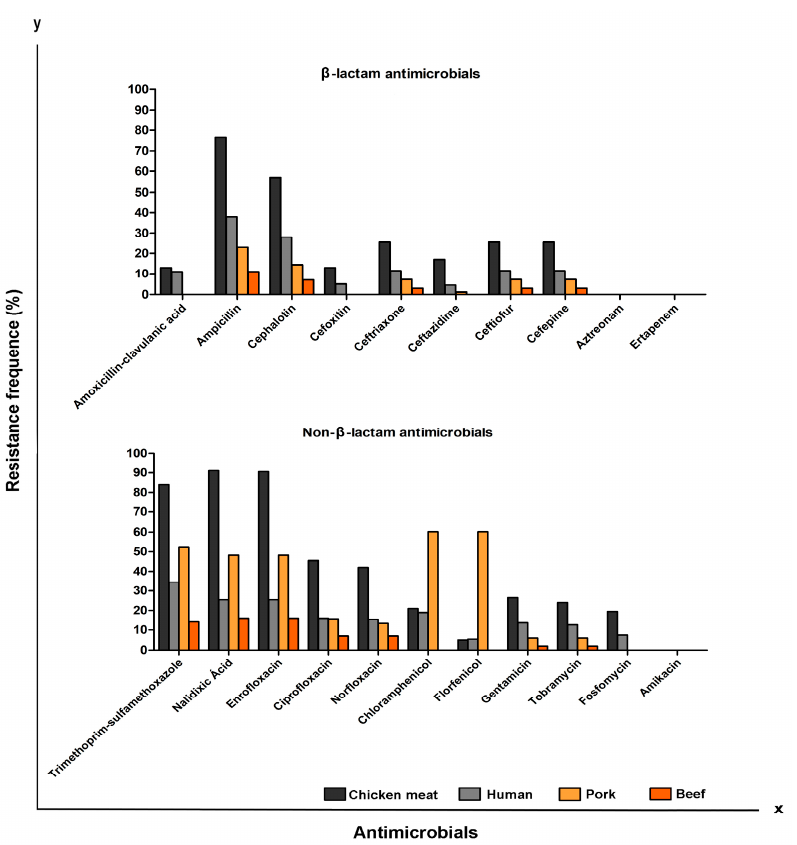
Figure 1. Comparison of the prevalence (%) of antimicrobial resistance in P. mirabilis isolated from chicken ( n = 200), pork ( n = 83), beef ( n = 100), and UTI-CA ( n = 200).